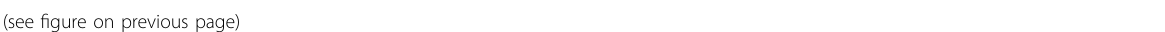
(see fi gure on previous page) Fig. 4 CXCR4 mediated DR5 regulation is independent of CXCR4-CXCL12 signaling. A HT-29 cells were treated with either different concentrations of paclitaxel (9, 18, 37, 75, 150 nM) or AMD3100 (5 μ M) alone or in combinations for 48 h and cytotoxicity was measured by SRB assay. Percent cell viability was tabulated. Columns, an average of triplicate readings of samples; error bars ± SEM. B Control and CXCR4 overexpressed MCF- 7 cells were treated with CXCR4 ligand CXCL12 (100 ng/ml) or CXCR4 antagonist AMD3100 (5 μ mol/L) for 12 h, and subjected to Western blot analysis for DR5 and β -actin. C HT-29 cells were either pre-treated with vehicle or AMD3100 (5 μ M) for 12 h, followed by treatment with CXCR4 ligand CXCL12 (100ng/ml) for different time points (0.5, 1, and 2 mins) and subjected to Western blot analysis for p-ERK and β -actin. D CXCR4 + and CXCR4 − HT-29 cells were fl ow-sorted and plated. After 5 days of culture, cells were stained with either APC-conjugated CXCR4 (CD184) and PE-conjugated DR5 or their respective matched isotype control antibodies and analyzed by FACS. In the upper panel, dot plots represent CXCR4 staining in unsorted, CXCR4 + sorted and, CXCR4 − sorted cells. In the lower panel histograms represent DR5 staining in the above-mentioned respective cells. E DLD-1, HCT-116, A-549, and MDA-MB-468 cells were stained with either APC-conjugated anti-human CXCR4 (CD184) or isotype control antibodies and analyzed by FACS. The cell surface expression of CXCR4 is represented in histogram overlays. F DLD-1, HCT-116, A-549, and MDA-MB-468 cells were seeded on coverslips for 24 h and subjected to immuno fl uorescence staining for CXCR4 and analyzed by confocal microscopy; Scale bar 10 μ m. G DLD-1, HCT-116, A-549, and MDA-MB-468 cells were made stable for CXCR4 knockdown via shRNA mediated lentiviral transduction and scramble shRNA transduced cells were used as control. Immunoblot analysis of CXCR4 and DR5 protein in control or CXCR4 knockdown cells are shown; β -Actin was used as an internal protein loading control. H – L MCF-7 and HCT-116 cells were transfected with scrambled, wild type CXCR4, CXCR4 L86P , or CXCR4 δ 242-248 containing vectors and cultured. After 48 h, cells were either stained with APC-conjugated anti-human CXCR4 (CD184)/isotype control antibodies and analyzed by FACS, or subjected to western blot or total RNA isolation. H The cell surface expression of CXCR4 is represented in histogram overlays. I , K Immunoblot analysis of CXCR4 and DR5 protein in control, wild type CXCR4, CXCR4 L86P , or CXCR4 δ 242-248 transfected MCF-7 and HCT-116 cells; β -Actin was used as an internal protein loading control. Western Blot densitometric quanti fi cation numbers are shown above the loading control blot of all immunoblot studies. J , L Fold change in DR5 mRNA expression was measured by RT-qPCR as described in Materials and Methods. Data are representative of three independent experiments, resulting from duplicate readings of two different samples; Columns, average value of DR5 mRNA expression; bars ± SEM. *, p < 0.05, compared with respective